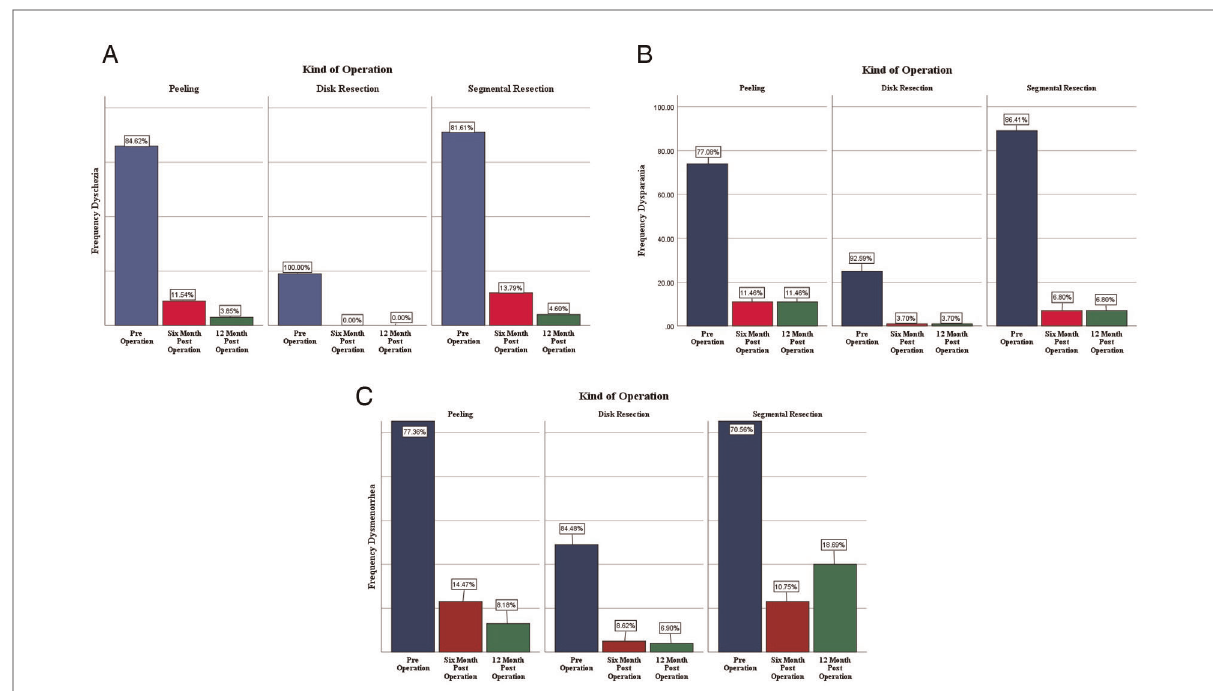
FIGURE 1 Comparison of dyschezia ( A ), dyspareunia ( B ) and dysmenorrhea ( C ), before surgery, six and 12 months after surgery based on the type of colorectal endometriosis surgeries.